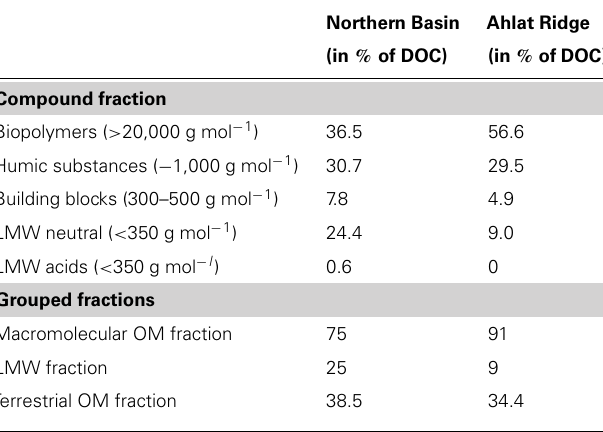
Table 1 | Pore water DOC composition of Northern Basin andAhlat Ridge gravity cores (sum of all samples), including the individual fractions obtained in LC–OCD.